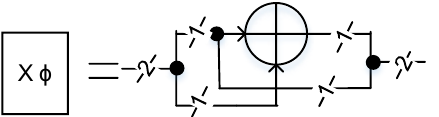
Figure 4. Multiplier in the composite field GF ((2 2 ) 2 ) . The 2 × 2 multiplier in the GF ((2 2 ) 2 ) employs three XOR gates and three AND gates.